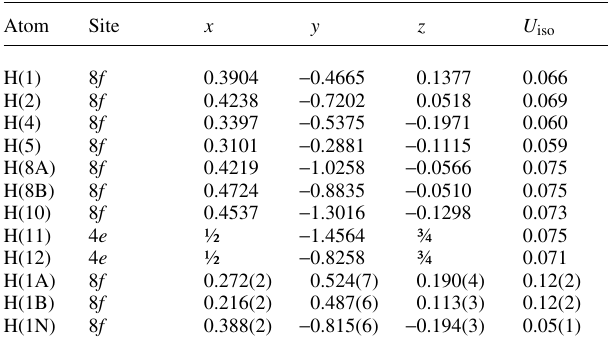
Table 2. Atomic coordinates and displacement parameters (in Å 2 )